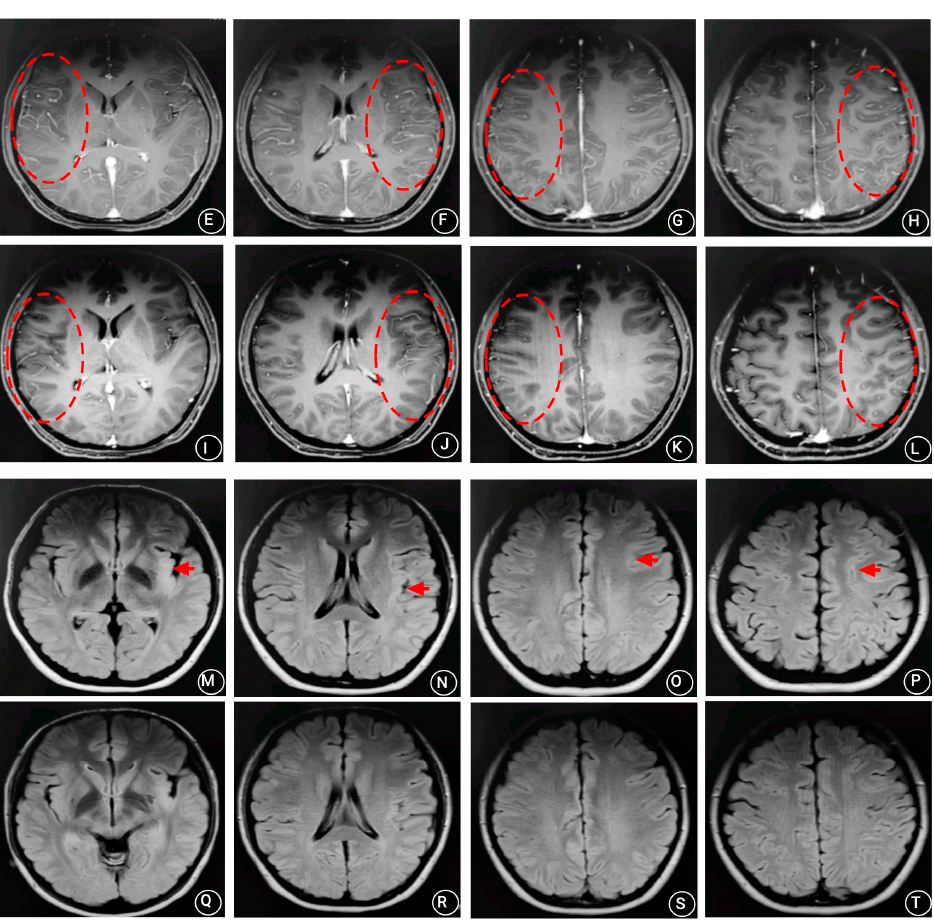
Figure 2. Brain MRI of the patient at admission (2 weeks after symptom onset) showing extensive hyperintensity of the left-sided frontoparietal, temporal, occipital, and insular cortices on FLAIR imaging (arrows) ( A – D ). Post-contrast MRI revealed linear enhancement in frontoparietal, temporal, and occipital sulci bilaterally (ellipses) ( E – H ). Post-contrast MRI after 2 weeks of treatment showed that the linear enhancement in these areas was less than before (ellipses) ( I – L ). MRI repeated after two months. The FLAIR signal had decreased in the left insular lobe, and the abnormal signal was partially absorbed in the left frontoparietal, temporal, and occipital cortices (arrows) ( M – P ). MRI performed almost one year after the initial symptom onset showed the FLAIR signal had decreased in the left insular lobe, and the abnormal cortical signal of FLAIR has disappeared in the original left frontal, temporal, parietal, and occipital lobes ( Q – T ).